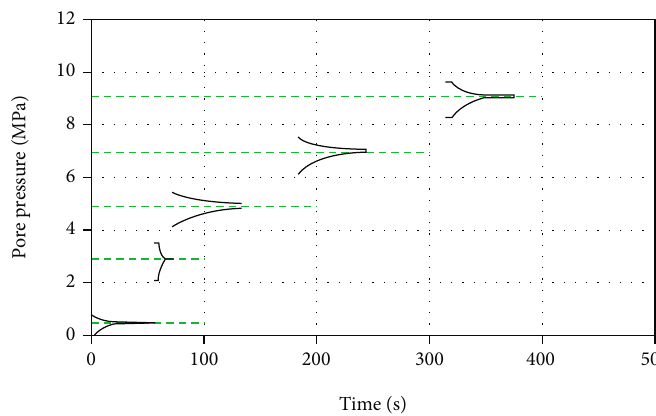
Figure 6: Pulse-decay pressure responses for the CO